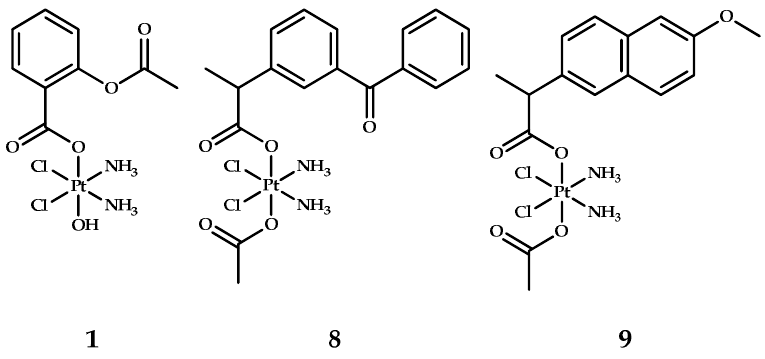
Figure 7. Asplatin 1 and cisplatin-based platinum(IV) prodrugs 8 and 9 with ketoprofen and naproxen as axial ligands.